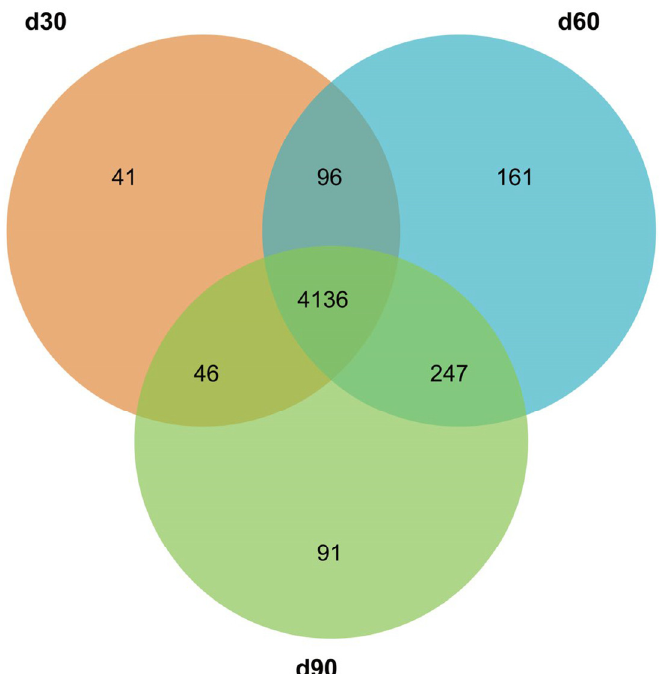
Figure 2. Venn diagram of all miRNAs. It has identified 4818 miRNAs in antler growth centers of Cervus elaphus kansuensis at three development stages (30 d, 60 d, 90 d). Most of the miRNAs (4136) were co-expressed in three libraries. Only 41, 161, and 91 miRNAs were specially expressed in d30, d60, and d90 antler growth centers.